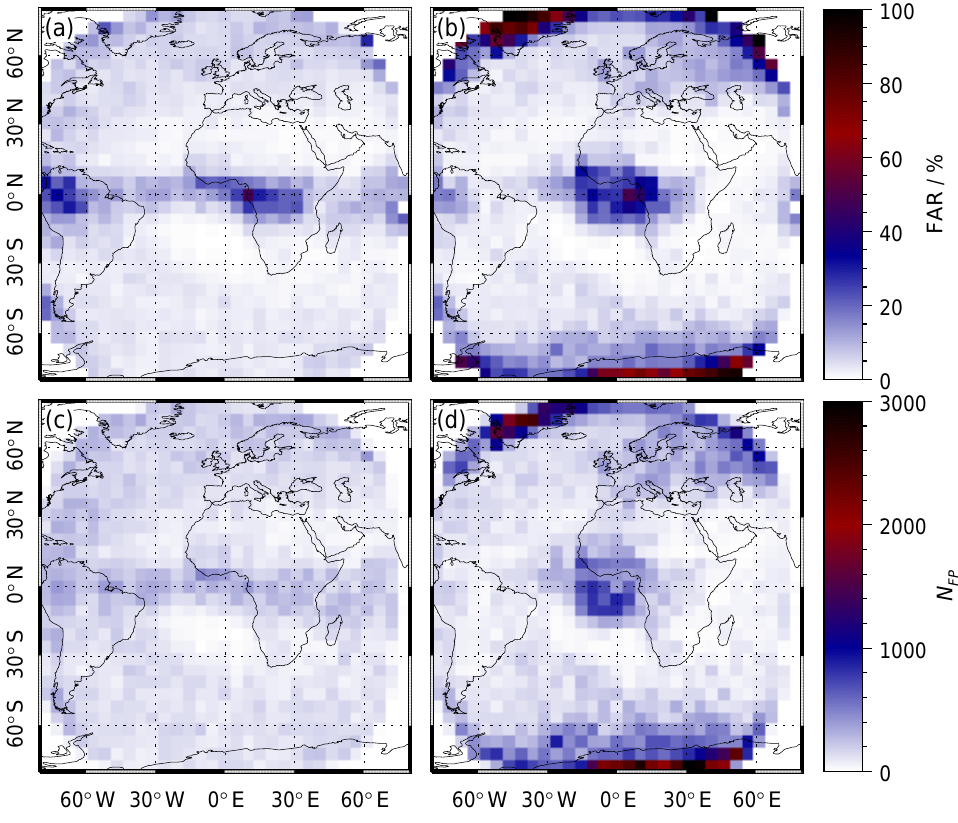
Figure 6. Top: the FAR of the CCF retrieved by CiPS (a) and COCS (b) . Bottom: the absolute number of false alarms by CiPS (c) and COCS (d) . Approx. 3.3 millions cirrus-free points are included in the validation dataset.